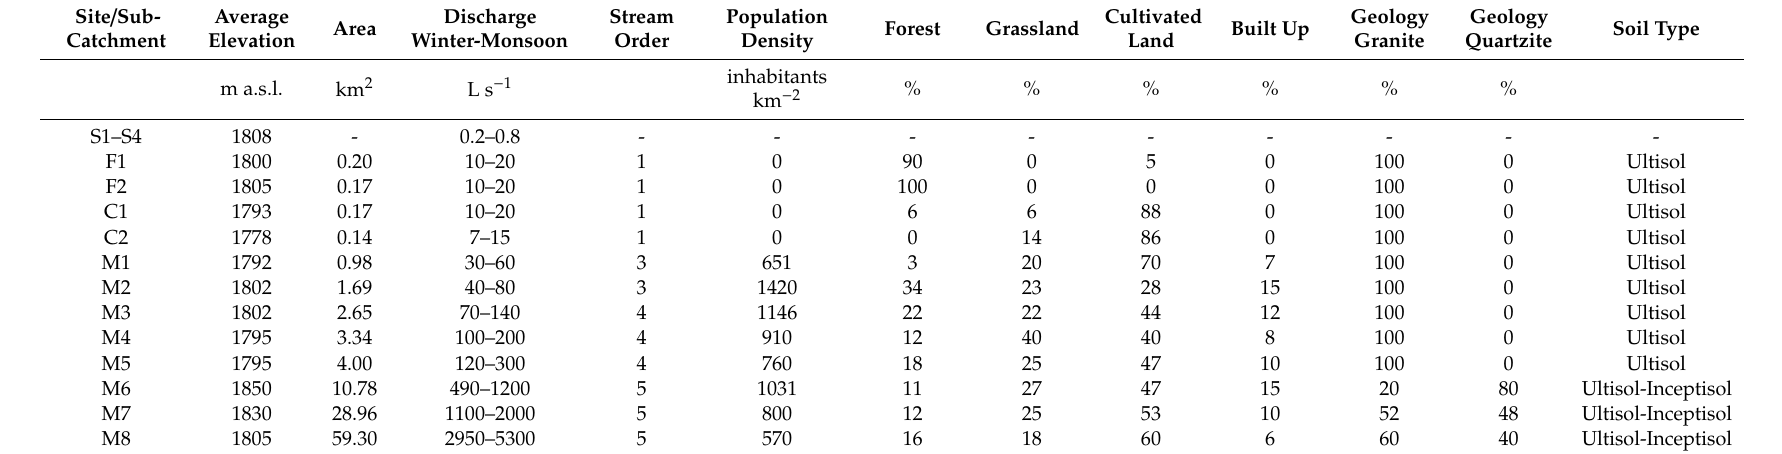
Table 1. General information on the sampling sites in the Nongkrem and Umiew nested catchments system, Meghalaya Plateau, Northeast India. Nongkrem catchment: